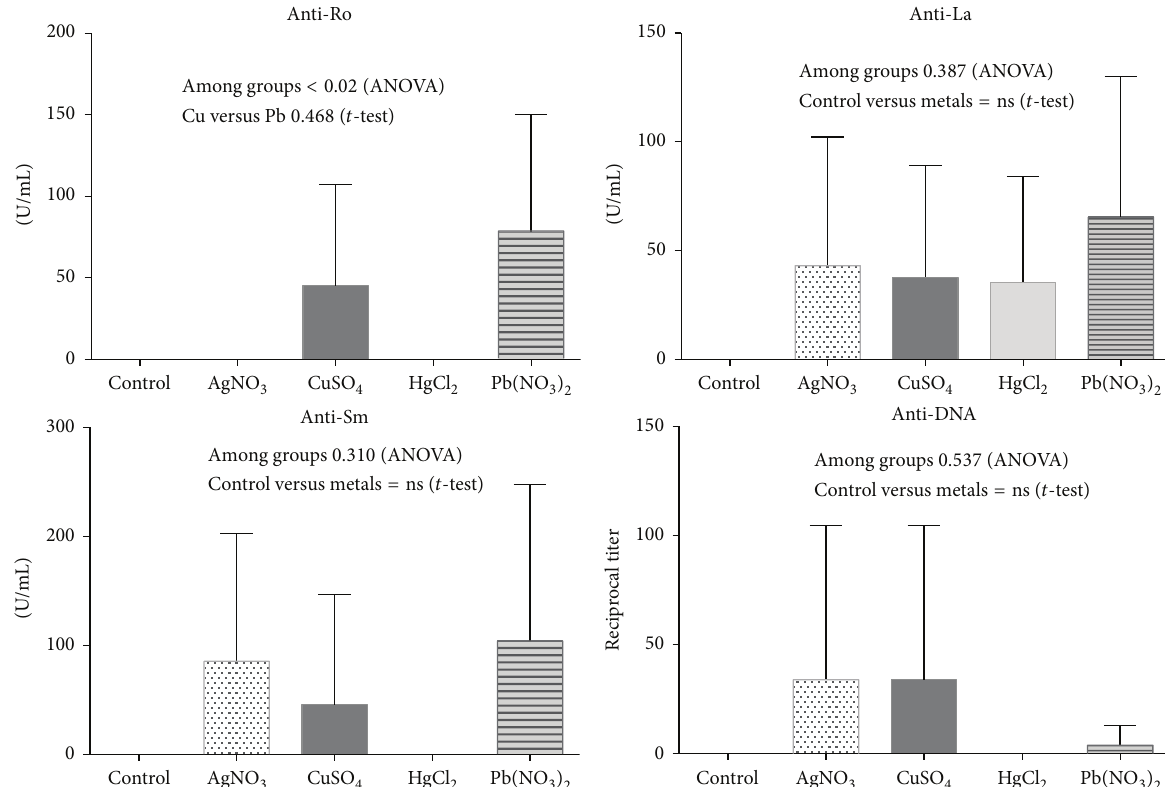
Figure 3: Antinuclear antibody specificity determined by ELISA (anti-Ro, anti-La, and anti-Sm) and the anti-DNA titers determined by indirect immunofluorescence with Crithidia luciliae . The graphs show the mean and SD.